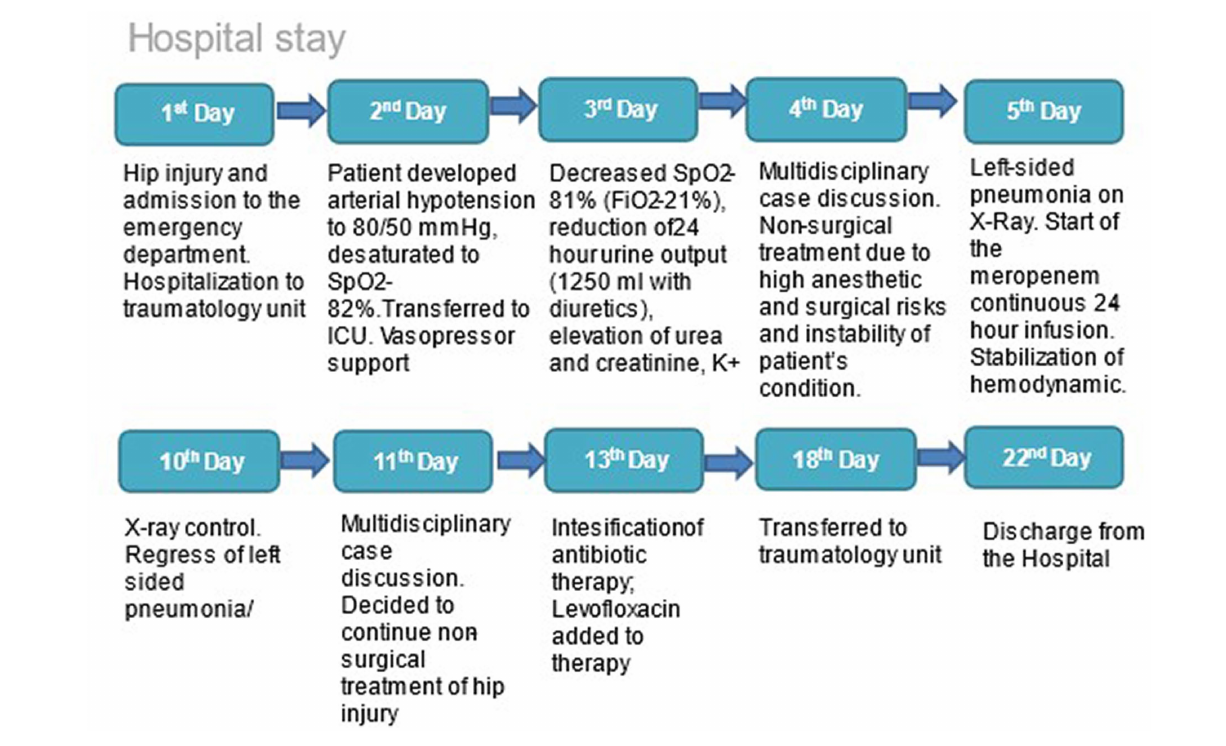
FIGURE 1 Chronology of the patient’s medical history from the moment of admission to discharge from the hospital.